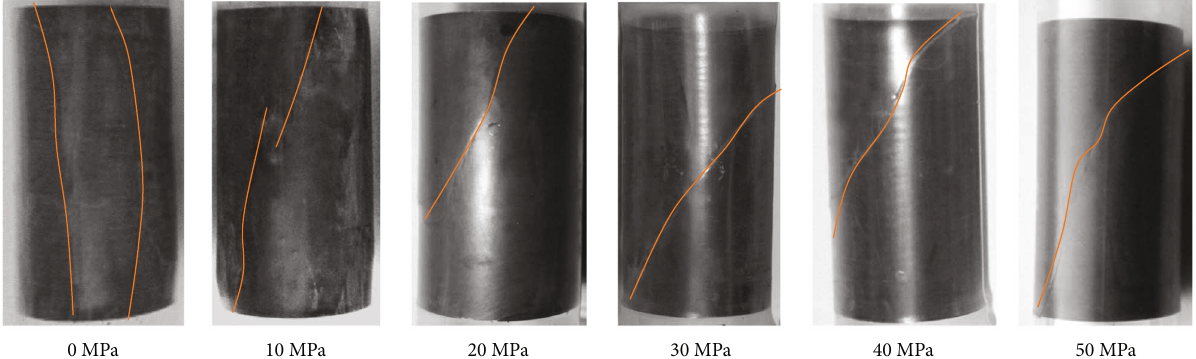
Figure 3: Broken cores after compression with di ff erent con fi ning pressures.